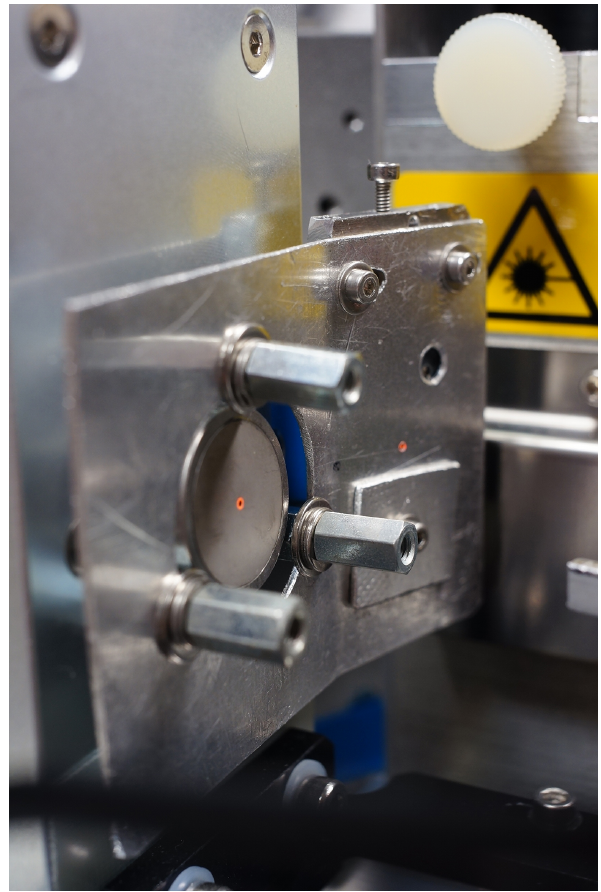
Figure 3. In the front, the image of an artificial source covering about the same angle as the solar disc is seen on the primary field stop. The support for the secondary field stop is mounted on the pri- mary detector. The secondary field stop itself is realised as a 0.8mm hole in the aluminium sheet. The image of the source on the sec- ondary field stop is seen to the upper right from the centre of the image. The final alignment of the image position with respect to the position of the secondary field stop is performed by fine adjustment of the plane mirror.